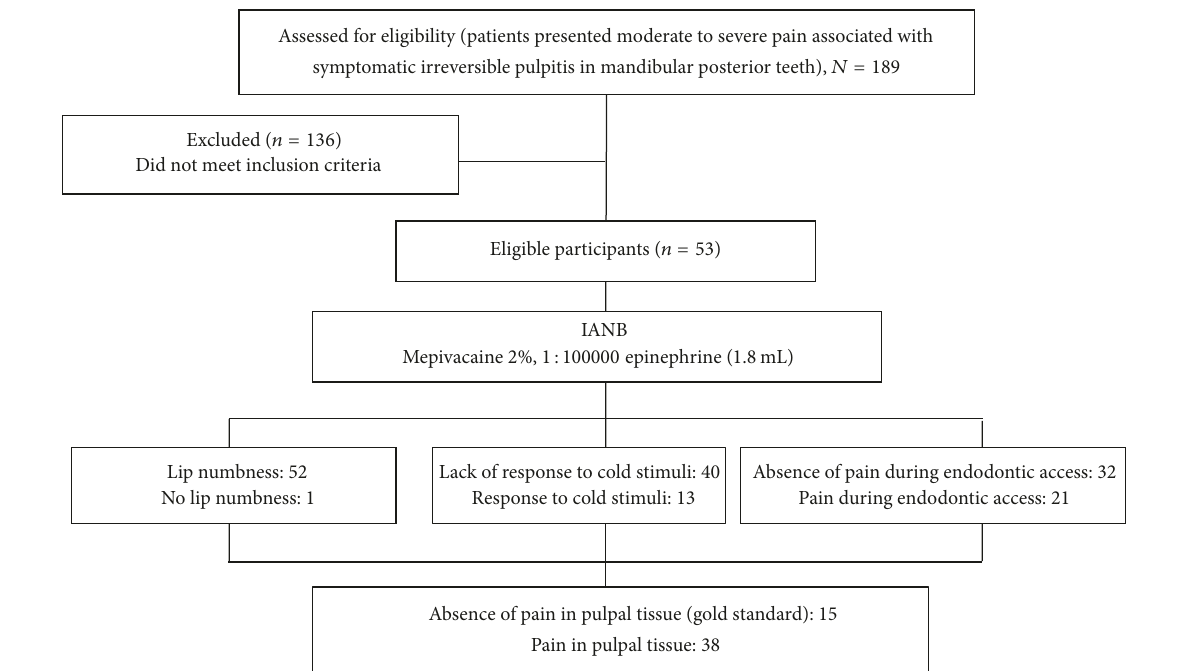
Figure 1: A flowchart of the clinical tests performed to predict anesthetic failure.